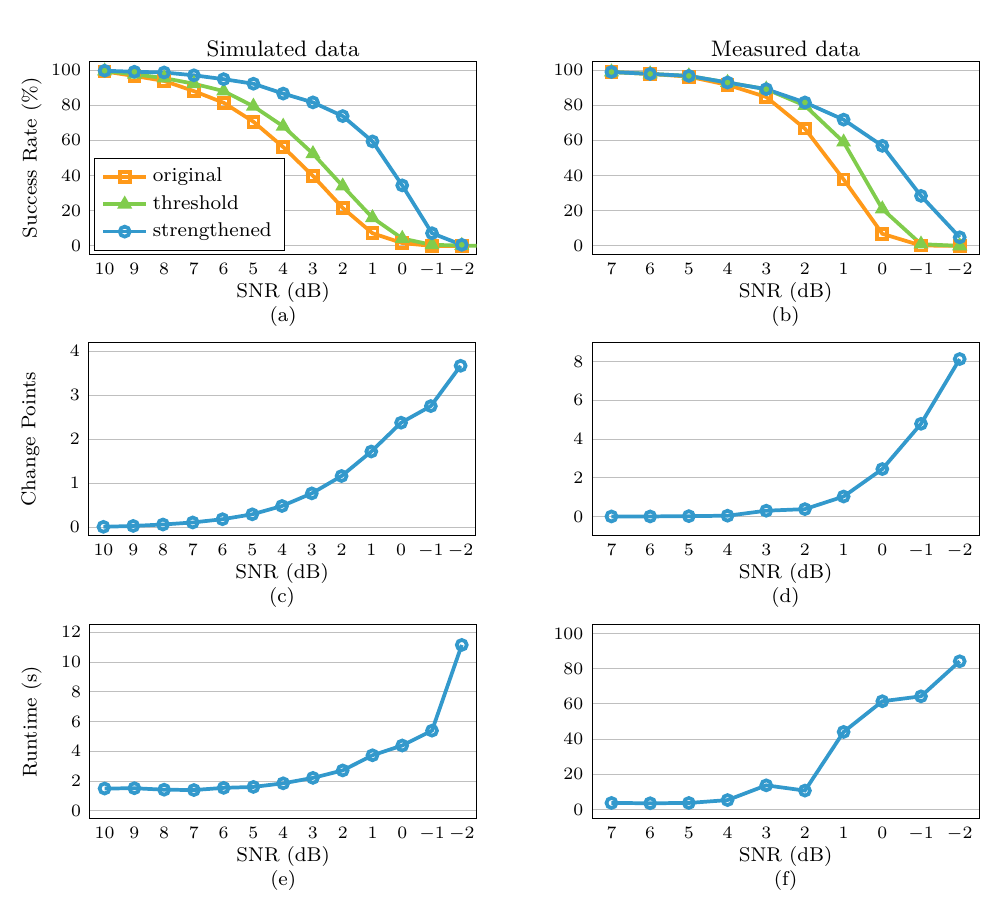
Figure 4: (a, b) Success rate of the basic H-CPA attack (without correction), corrected by the error-detection method based on thresholds [CWT13], and strengthened by the proposed methodology. (c, d) Average number of change points detected by our methodology. (e, f) Average runtime of the successful attacks with our error detection and correction methodology. All these quantities are presented as a function of the SNR of the input power traces, which have been tuned by adding white Gaussian noise. Fig. 4(a, c, e) show the results obtained by the H-CPA attack on simulated data, while Fig. 4(b, d, f) show the results of the attack on the dataset measured by means of ChipWhisperer R (cid:13)